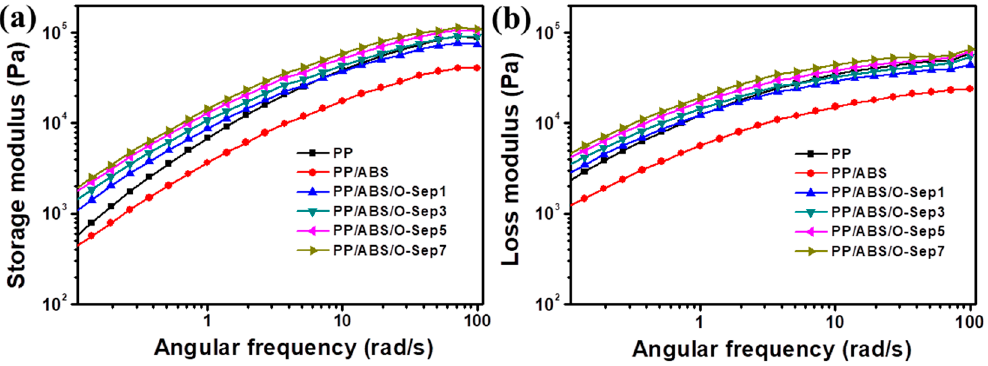
Figure 6. ( a ) Storage modulus and ( b ) loss modulus versus angular frequency for PP and PP/ABS/O-Sep nanocomposites at 210 °C.